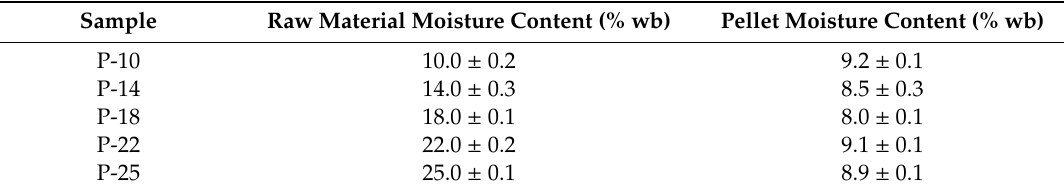
Table 2. Moisture content of pellets versus moisture content of raw material.